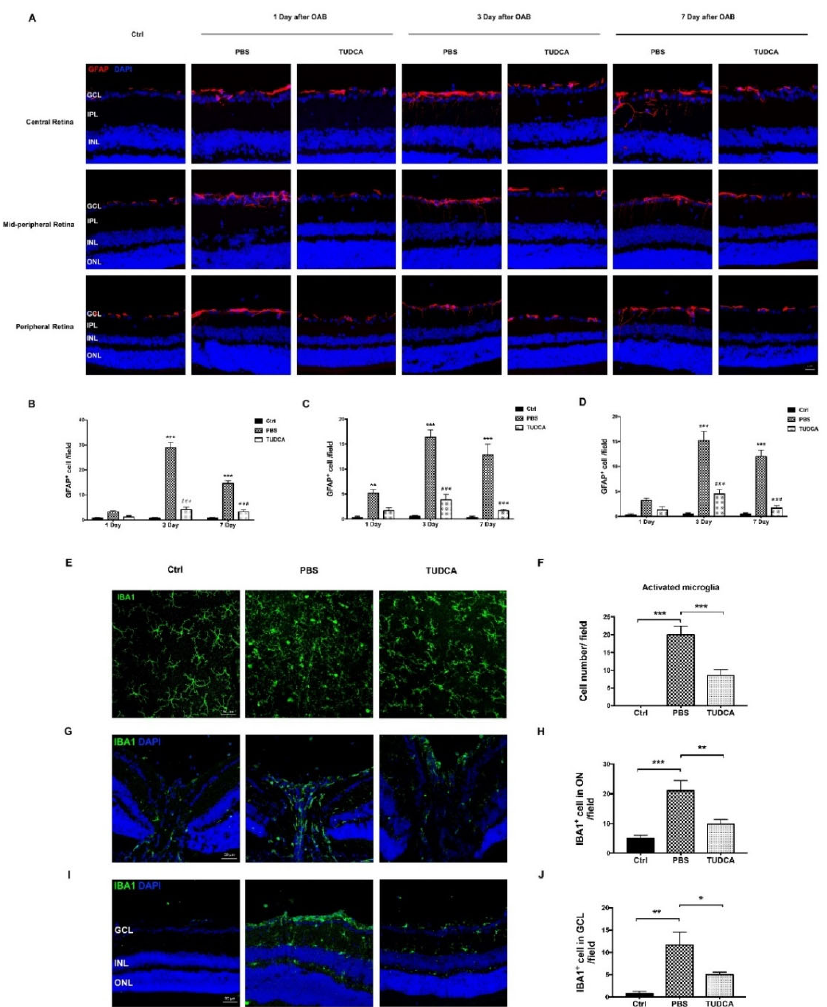
p = 0.0005; and GCL: 11.67 ± 2.83 cells/field versus 0.83 ± 0.40 cells/field, p = 0.0012; Figure 6G–J). The TUDCA treatment significantly reduced the number of GFAP + glial cells and amoeboid microglia and attenuated the microglia migration to the GCL compared with the PBS-treated group (Figure 6D,F–H).